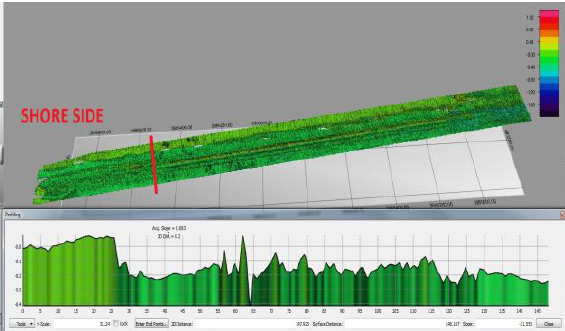
Figure 12: Change detection profile of shallow part.